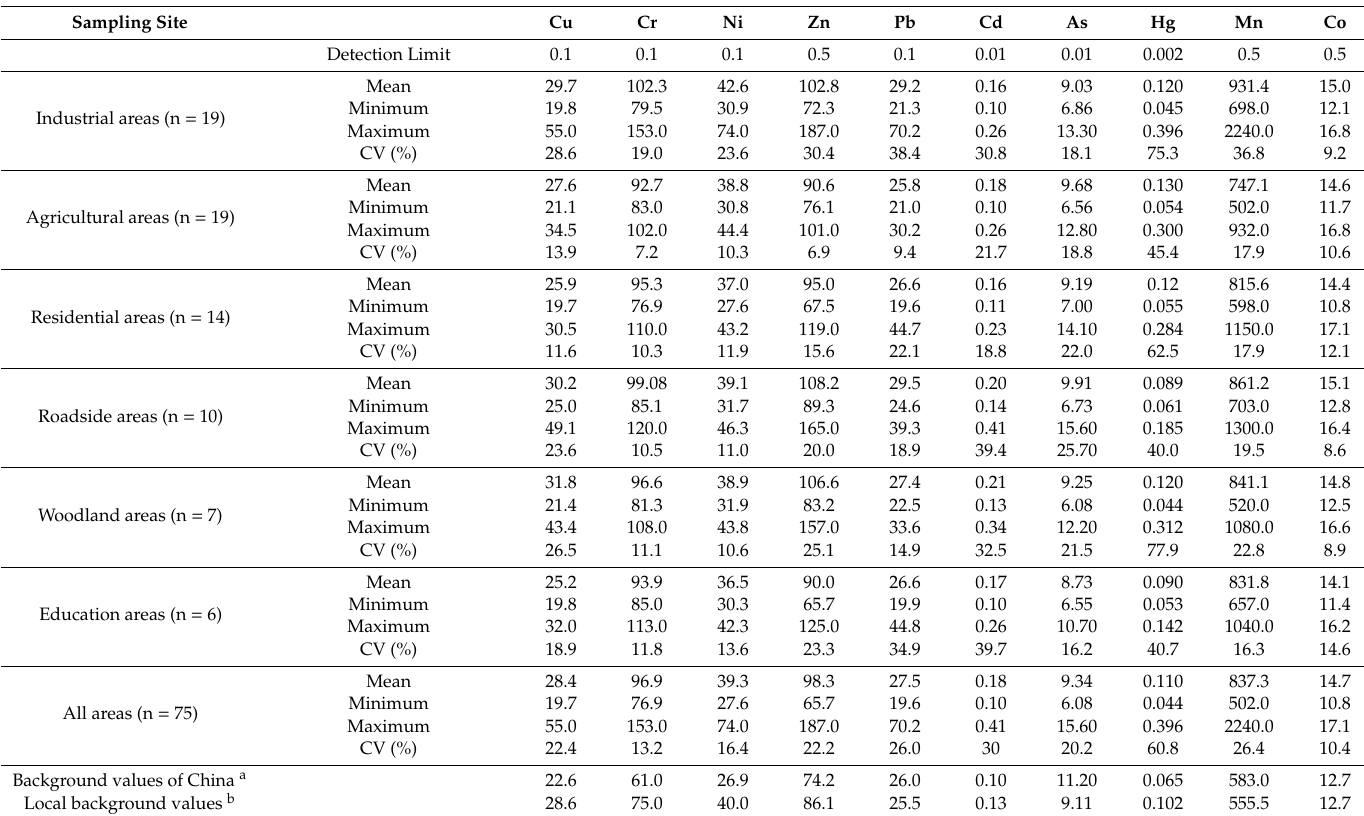
Table 3. The concentrations of 10 topsoil heavy metals (mg / kg) in the six functional